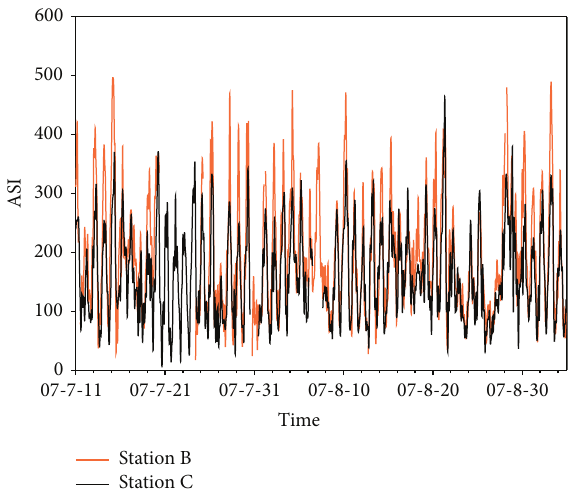
Figure 4: ASI measurements at station B and station C (July 11 to September 3, 2007).